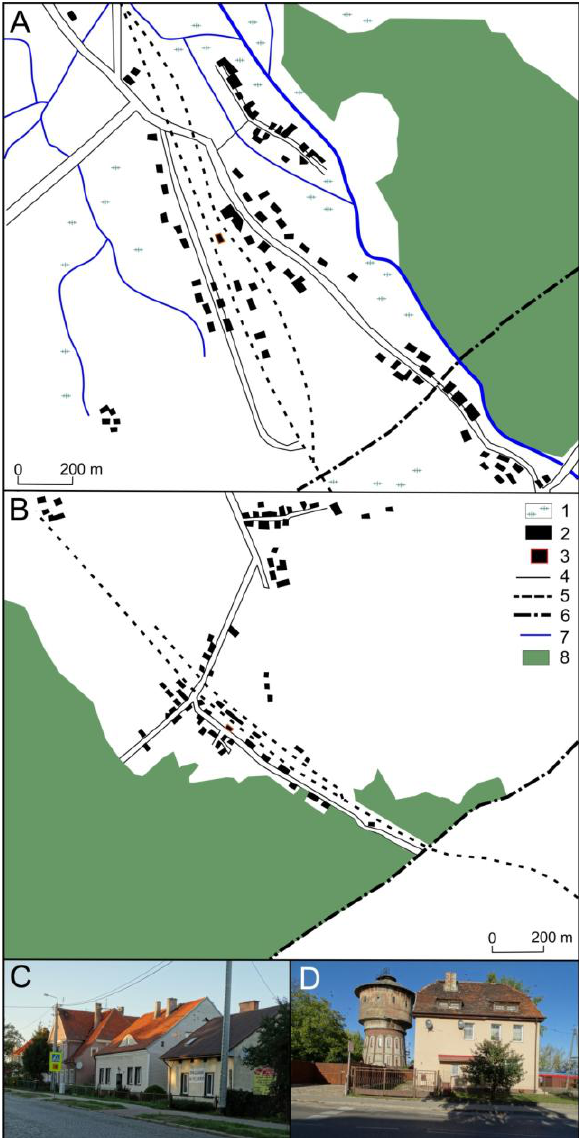
Fig. 6. Spatial layout of Prostki ( Prostken ) in the 1940s (A) and Iłowo-Osada ( Illowo ) in the 1930s (B), residential buildings of Prostki ( Prostken ) (C) and Iłowo-Osada ( Illowo ) (D) (Source: author’s own study based on Topographische Karte…, 1944 (A) Topographische Karte… 1938b